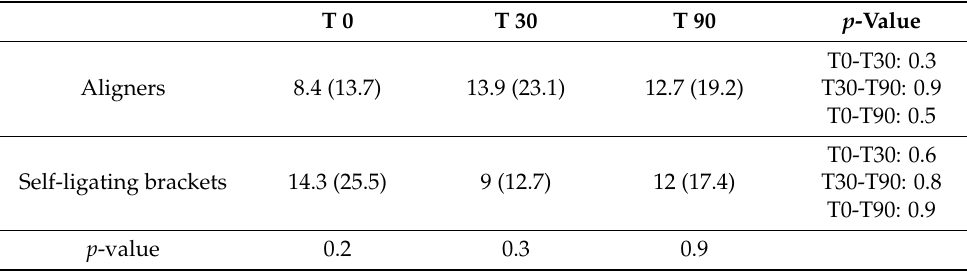
Table 3. Mean MPO values (SD) (mUl/mL) for the two techniques during the 90-day study period.